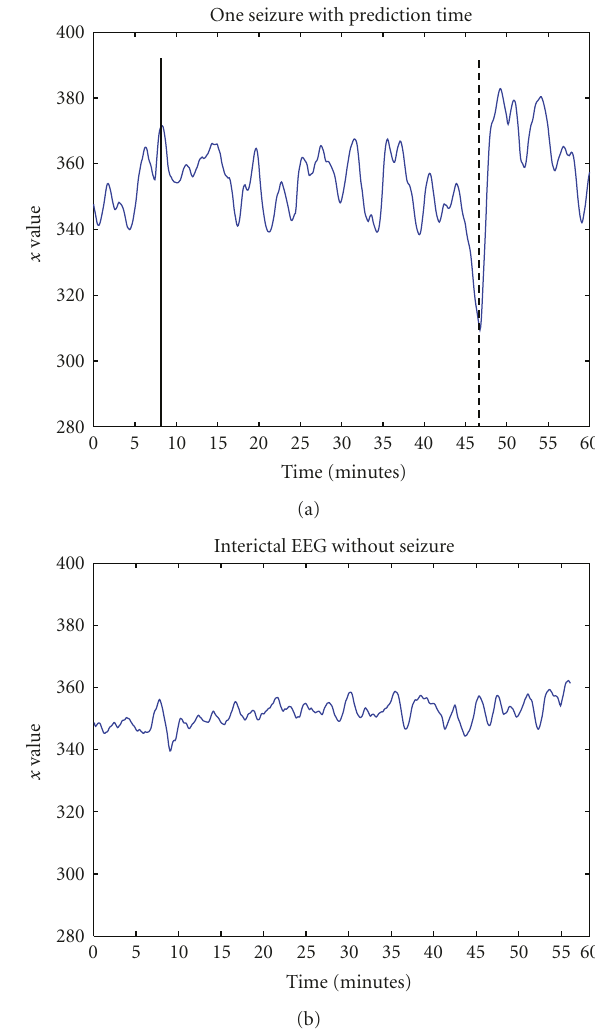
Figure 5: Ictal and interictal hidden variable x from one patient with epilepsy. The vertical solid line marks prediction time point and the vertical dashed line indicates seizure occurrence.